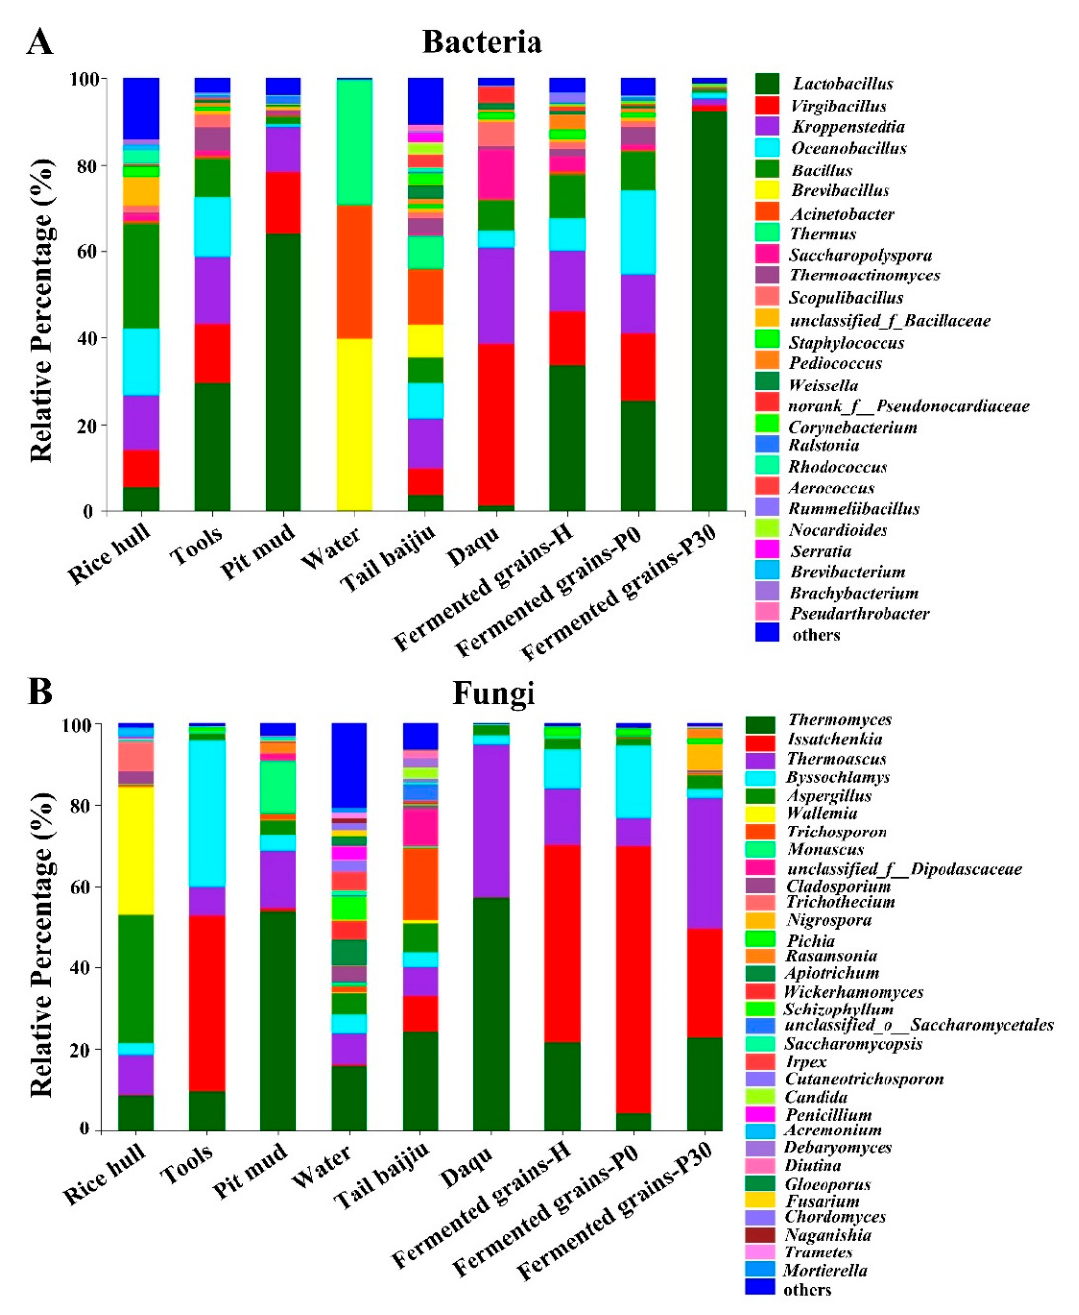
Figure 3. Microbial community structure in Daqu, environment, and fermented grains during the heap and pit fermentation of S auce ‐ flavor baijiu . Profile of bacterial taxa at the genus level ( A ). Pro ‐ heap and pit fermentation of Sauce-flavor baijiu . Profile of bacterial taxa at the genus level ( A ). Profile file of fungal taxa at the genus level ( B ). of fungal taxa at the genus level ( B